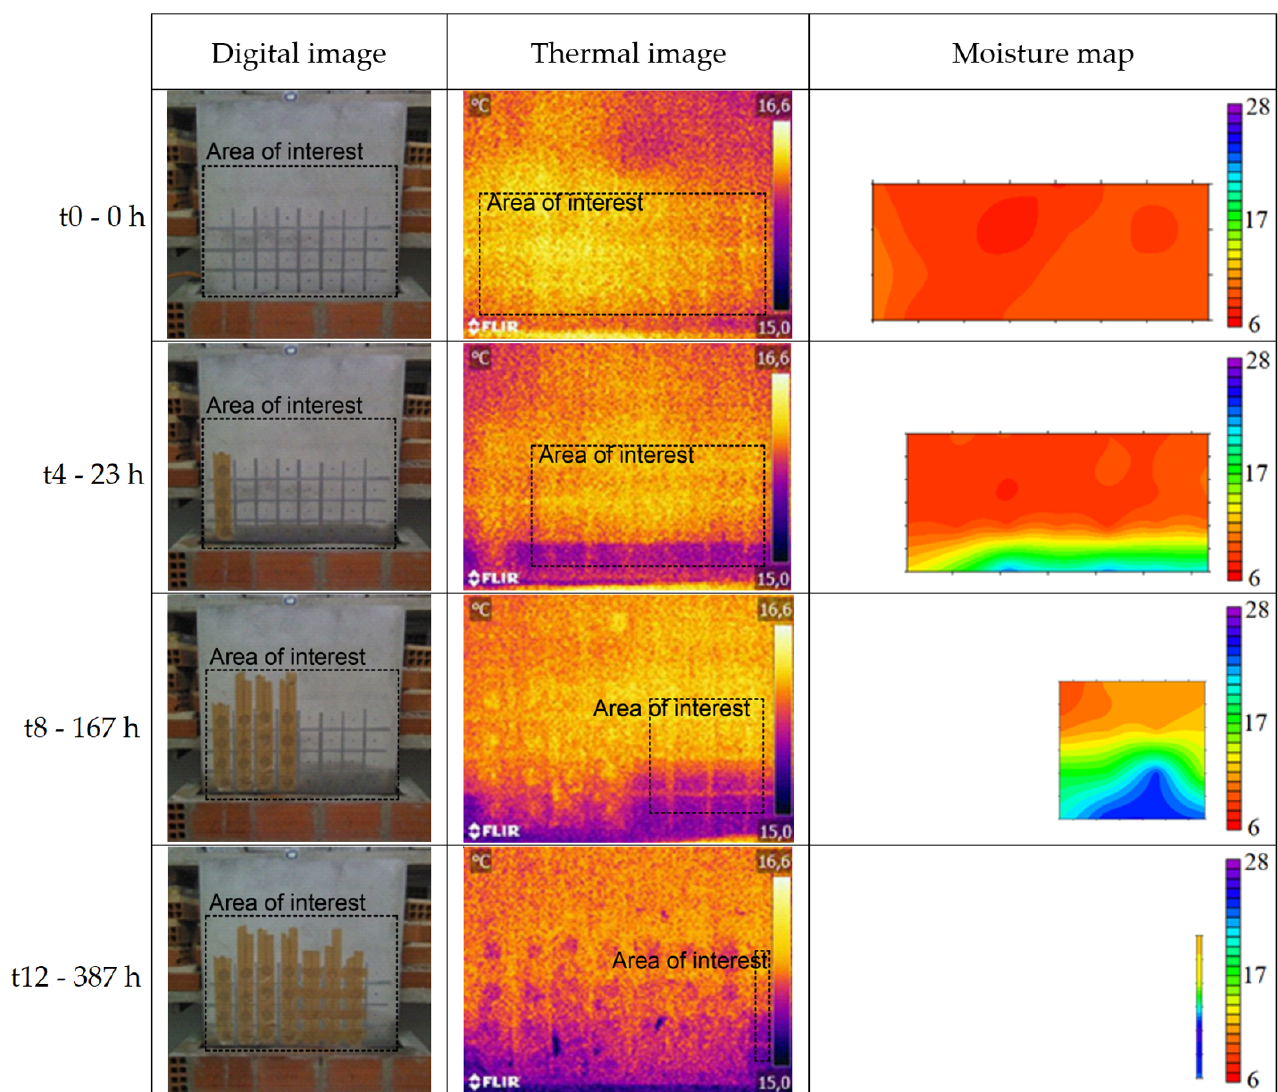
Figure 8. Digital images, thermal images, and moisture maps of the humidification test of the wall in the cold chamber.